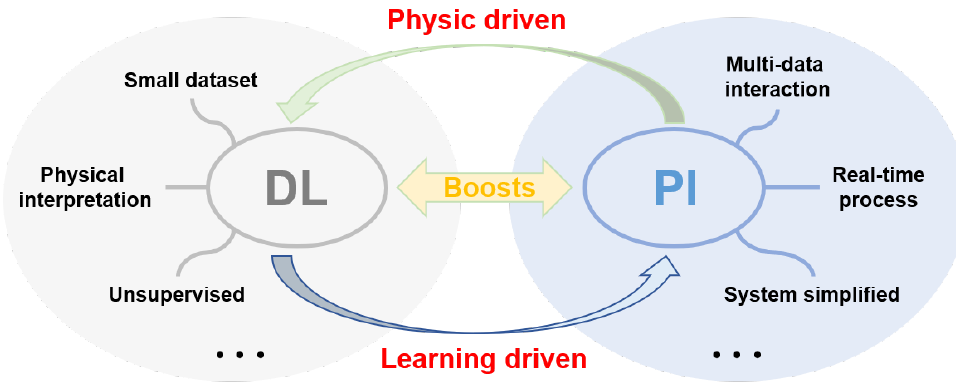
Figure 30. Synergy between PI and DL